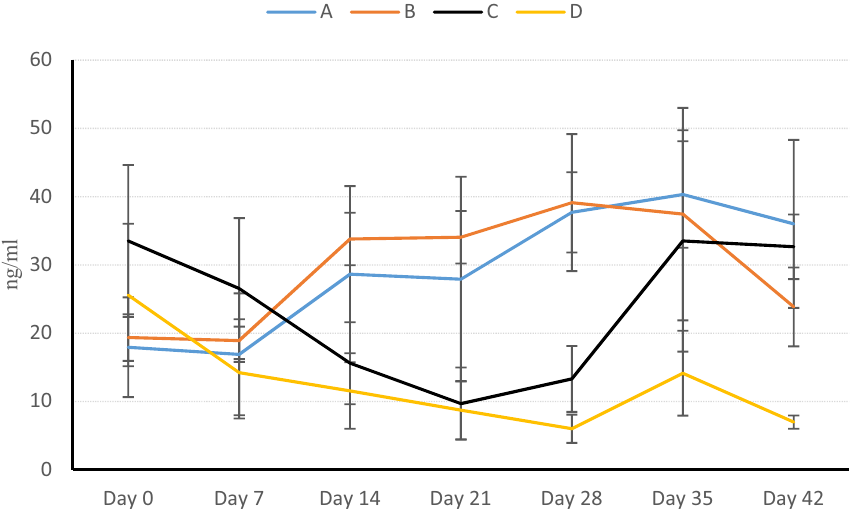
Figure 1. The 25D 3 variations in six weeks of experiment. Day 21 was the injection time of vitamin D injection in groups A and C. The procedure of variations in the six weeks in group B was increasing ( P < 0.05). The procedure of variations in the six weeks in group D was decreasing ( P < 0.01). The 25D3 concentration after the third week was not significantly different between groups A and B. however, it was significantly different between C and D ( P < 0.05). The procedure of variations was significant in all groups ( P < 0.05) except A day